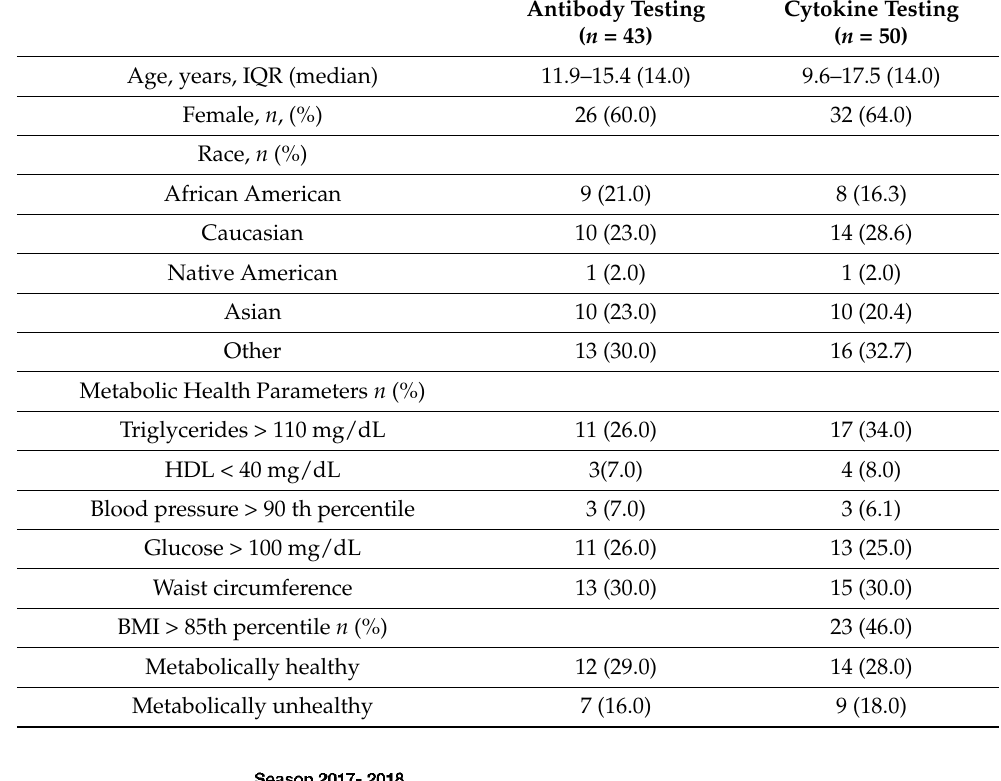
Table 1. Demographics and metabolic health profiles of patients in cohort with influenza antibody responses and cytokine profiles.